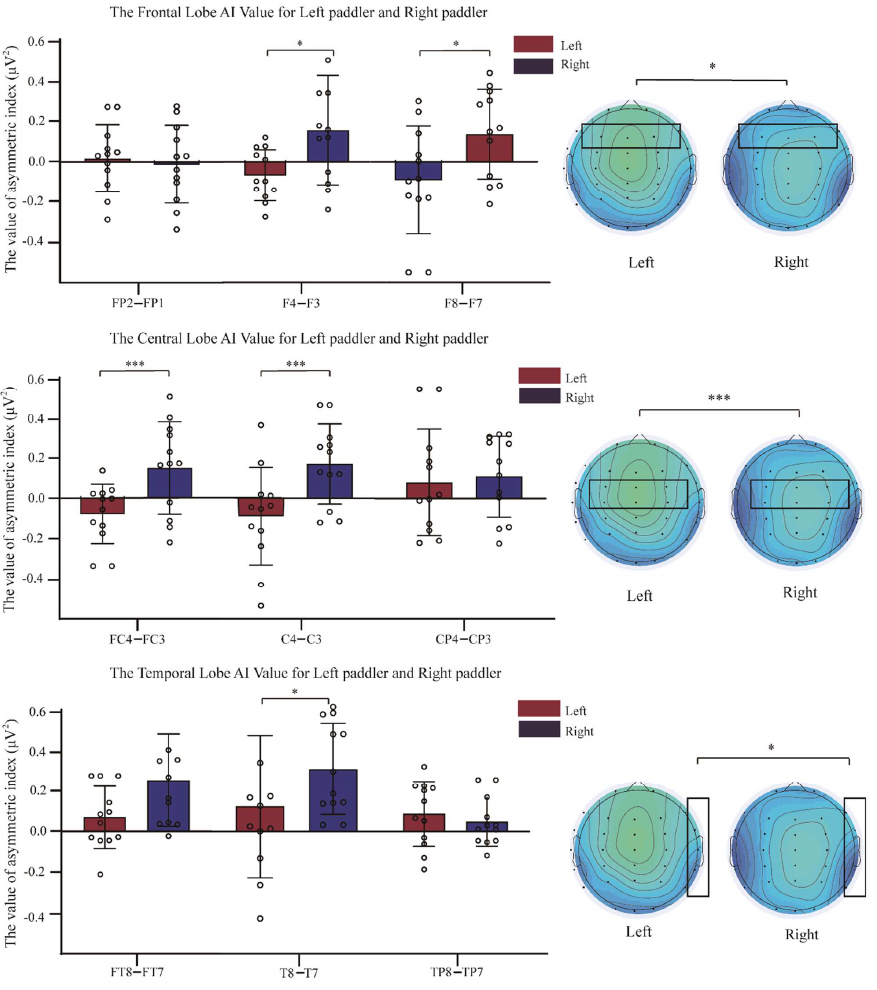
Figure 4. Brain area Asymmetric index (AI) in α band between the two groups. The AI of the right−paddlers group is significantly greater than that of the left−paddlers group after rowing. The brain energy image displays the distinct in left paddlers and right paddlers (black box). Error bars represent the SD. Asterisks indicate significant differences between conditions ( ∗ : p < 0.05, ∗∗∗ : p < 0.05). Left: left−paddlers group, Right: right-paddlers group. 2(paddlers) × 3(electrode pairs) mixed design analysis of variance was conducted for the frontal asymmetry. The results revealed interaction effects between the paddlers and electrode pairs in the θ band [ F (2, 82) = 4.789, p < 0.05, η 2 = 0.179]. Simple effect analysis found that the AI of F4 - F3 was a significant difference between paddlers [ F (1, 41) = 5.504, p < 0.05 ]. The AI of F4 - F3 in the right-paddlers group [ M = 0.066, 95%CL ( - 0.013, 0.145)] was significantly higher than that of the left-paddlers group [ M = −0.060, 95%CL (−0.139,